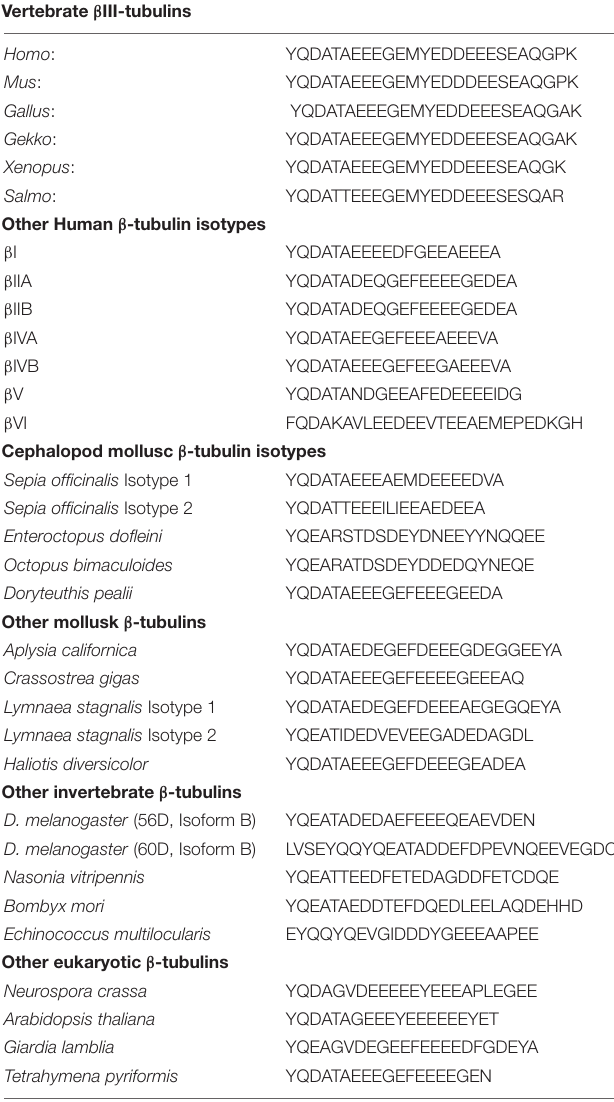
TABLE 4 | C-Terminal Regions of Various β -Tubulins. Vertebrate β